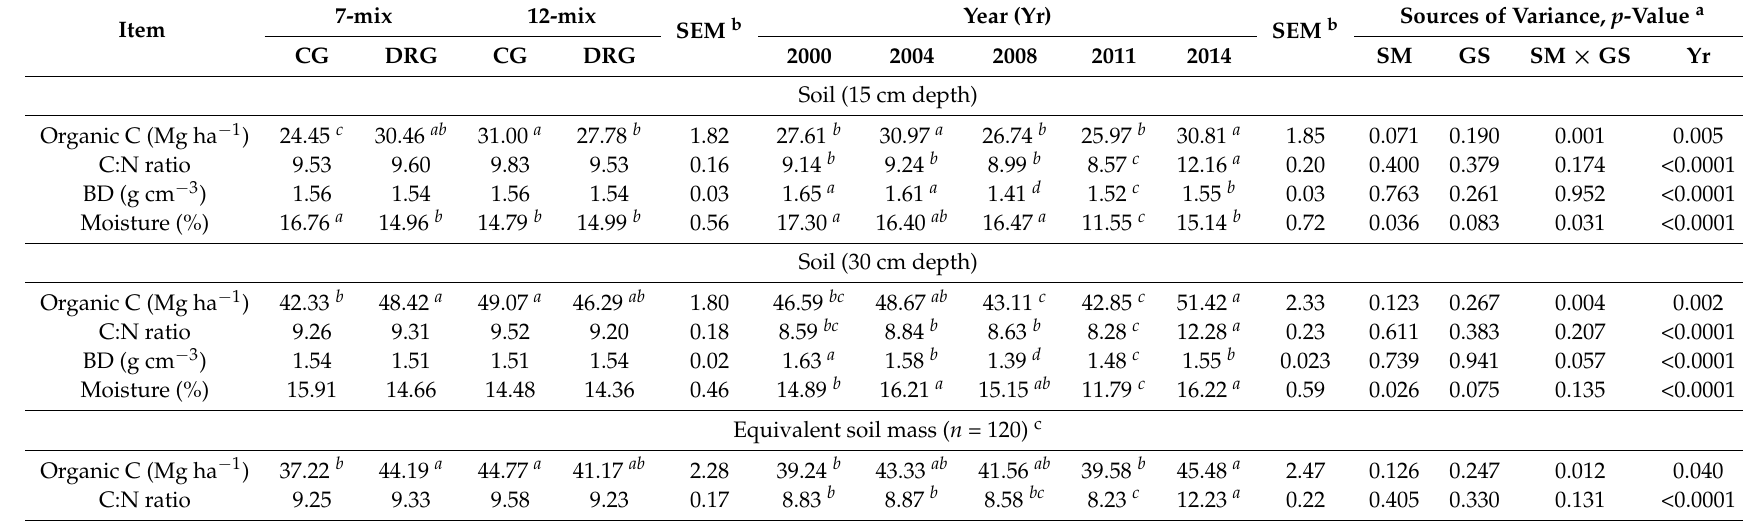
Table 6. Effect of seed mixture (SM, 7-mix, 12-mix) × grazing system (GS, continuous grazing (CG), deferred rotational grazing (DRG)) interaction and year (Yr) on soil properties (carbon (C), C to nitrogen (N) ratio, bulk density, moisture, equivalent soil mass) sampled at 0-15 and 0-30 (0-15 plus 15-30) cm depth ( n =